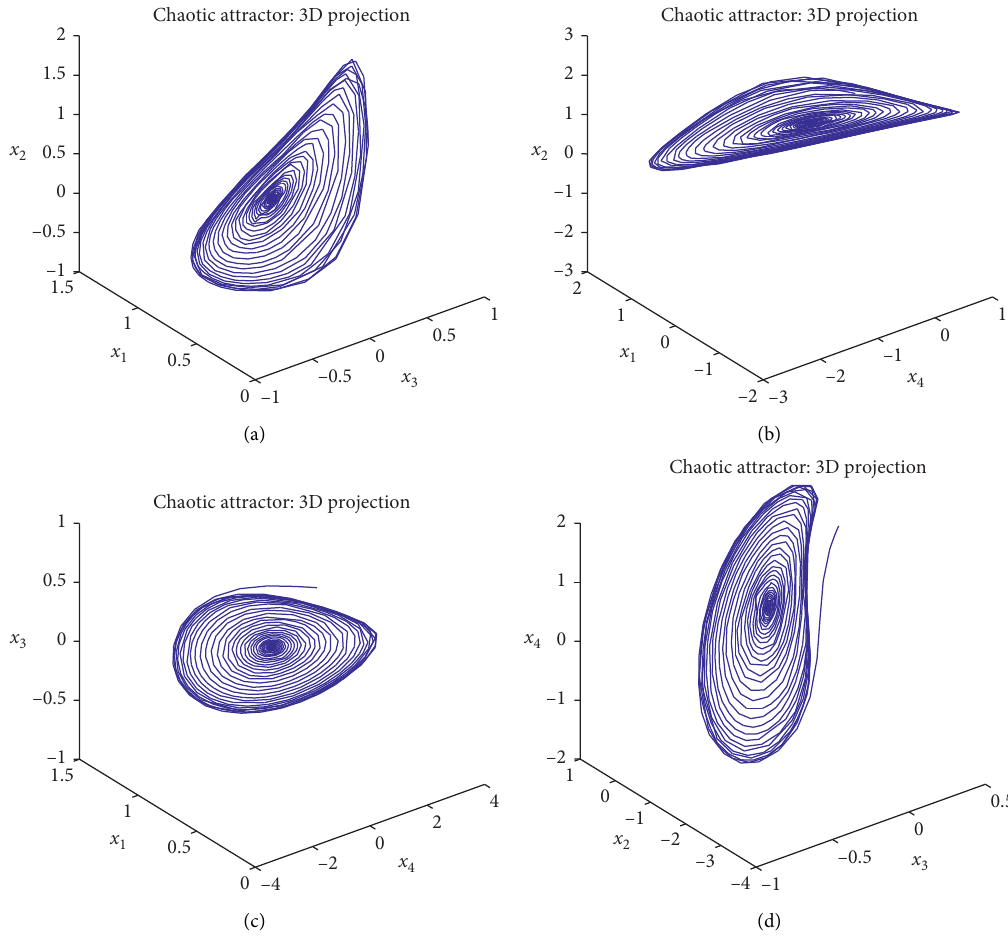
Figure 1: Chaotic attractors in three-dimensional projection.